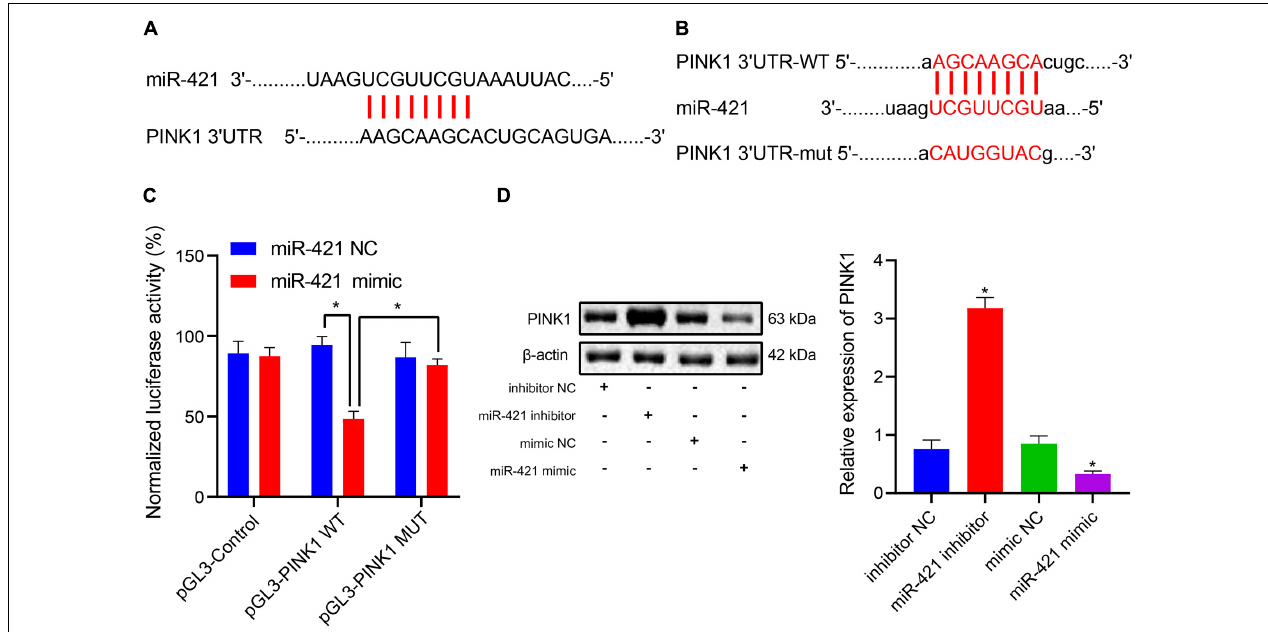
FIGURE 3 | miR-421 targets PINK1 and inhibits its expression in human embryonic NSCs. (A) The possible binding site of miR-421 and PINK1 3 (cid:48) -UTR. (B) The sequence of PINK1 3 (cid:48) -UTR WT and PINK1 3 (cid:48) -UTR MUT. (C) The binding of miR-421 to PINK1 confirmed by dual luciferase reporter assay. (D) The expression of PINK1 in the presence of miR-421 inhibitor or miR-421 mimic. * p < 0.05 compared with the inhibitor NC group or mimic NC group. Measurement data were represented as mean ± standard deviation. Data in (C) was analyzed by repeated-measures ANOVA. Data of multiple groups in (D) were compared by one-way ANOVA with Tukey’s post hoc test. Cell experiments were repeated for three